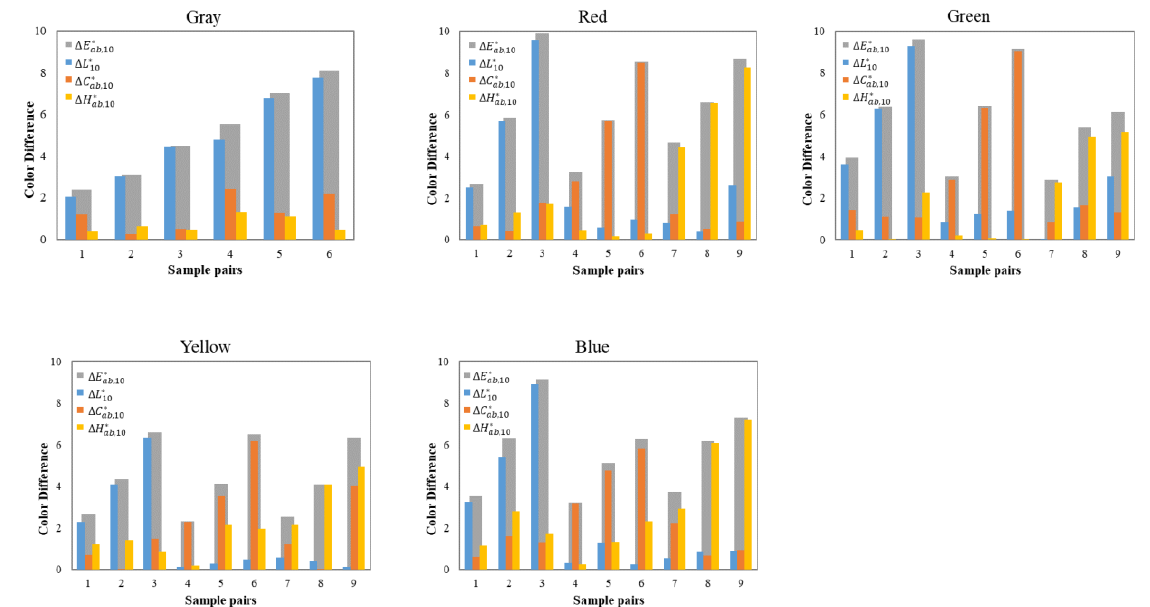
∆ L ∗ , ∆ C ∗ , ∆ H ∗ , ∆ E ∗ for the 42 pairs of 3D samples in Experiment 10 ab ,10 ab ,10 ab ,10